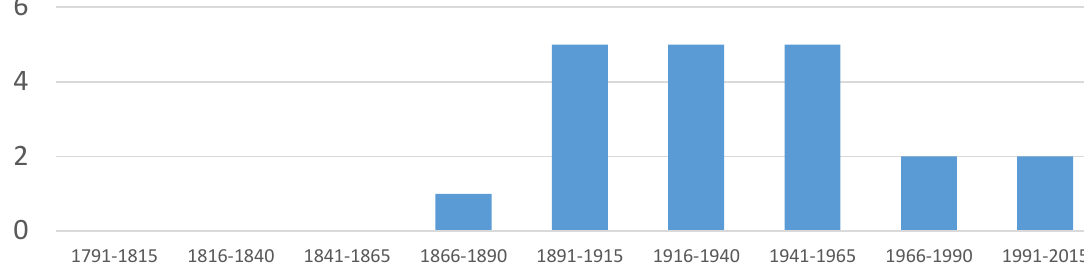
Figure 1. Evolution of the January effect: case of the US stock market during 1791–2015*